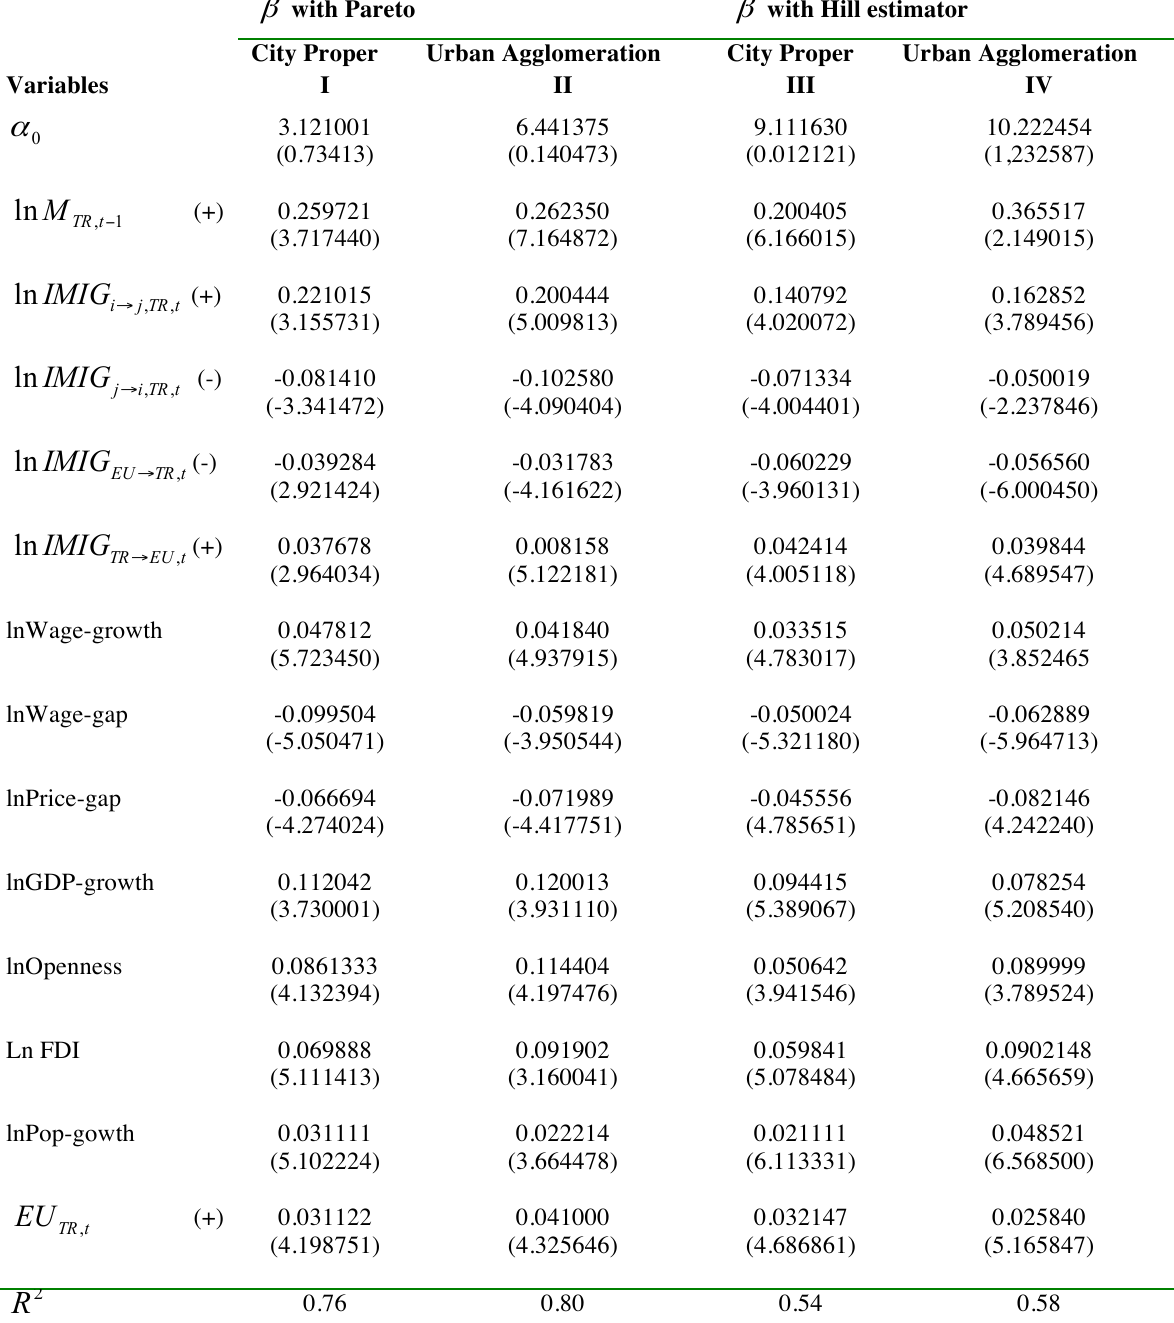
Table 3: The impacts of the variables on the city-size distribution of Turkey with Pareto with Hill estimator City Proper Urban Agglomeration City Proper Urban